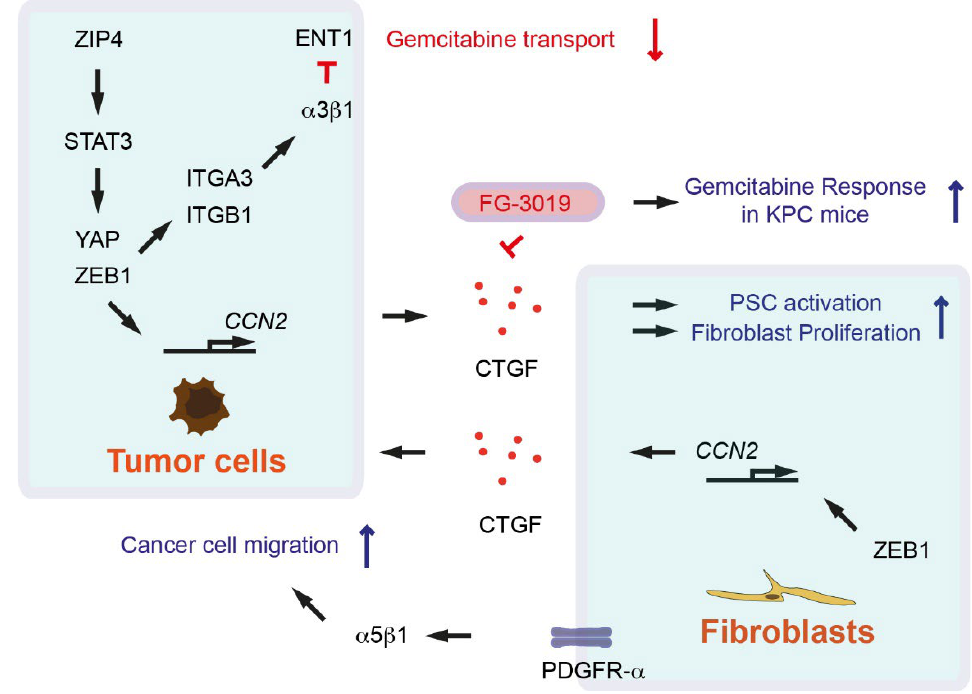
Figure 1. Growth factors as paracrine factors for cancer-associated fibroblasts (CAFs) and tumor cells. Arrows indicate activation or induction symbols. The inhibition symbols are colored in red . Table 1. Overview of autocrine, paracrine, and paracrine-reciprocal factors secreted from cancer- associated fibroblasts and tumor cells.